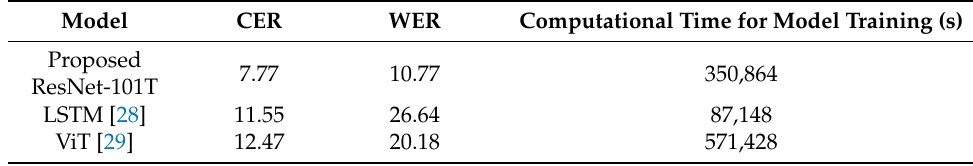
Table 5. Result comparison of Transformer and LSTM.